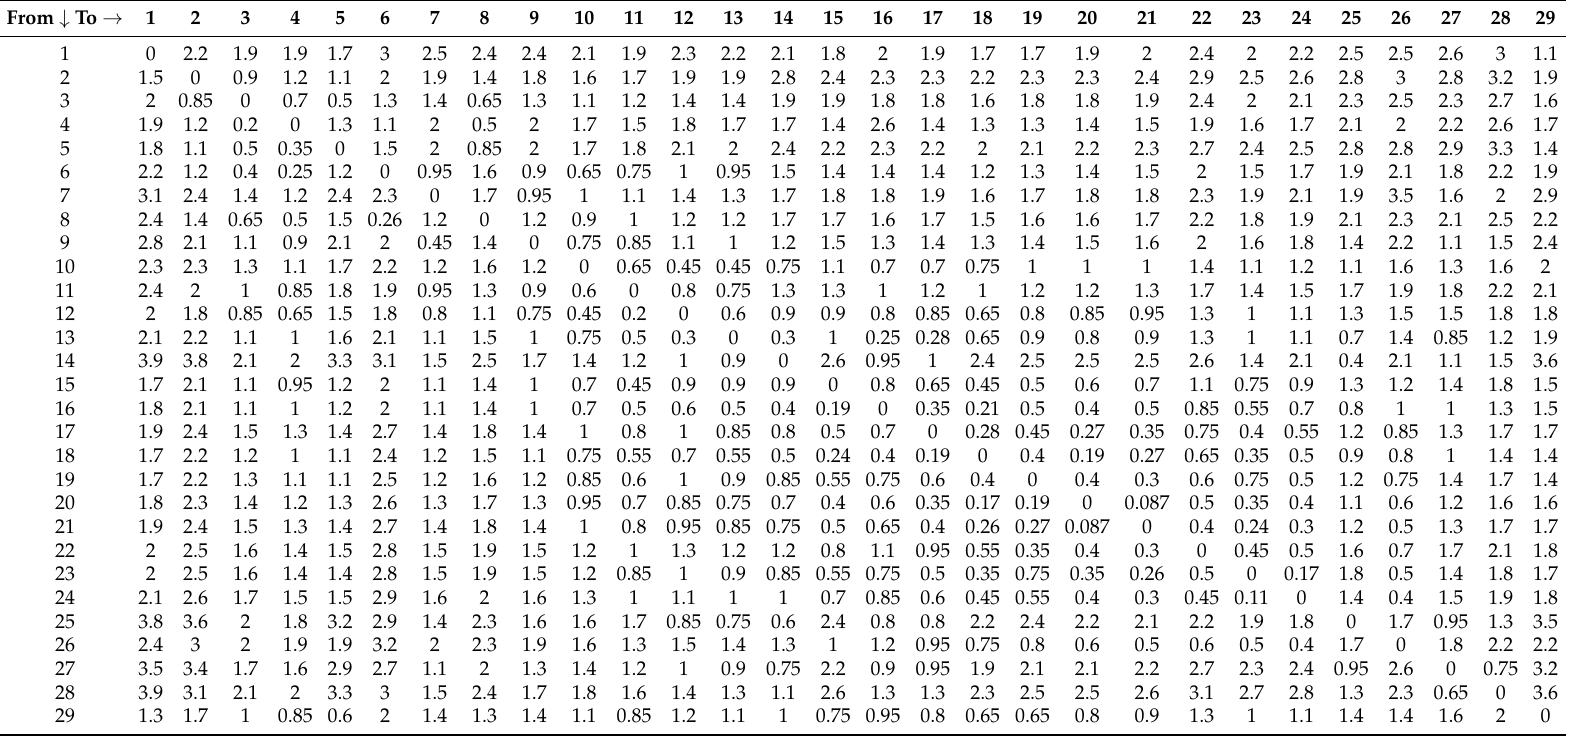
Table A4. Distances of the 29 locations in